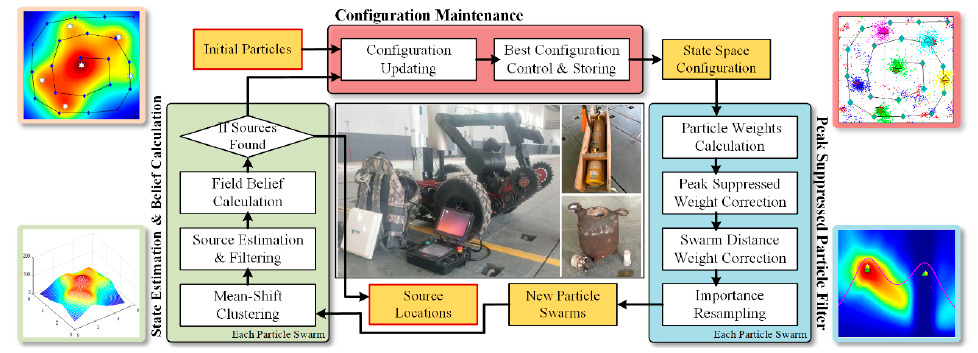
Figure 3. Flow diagram of the proposed PSPF algorithm.